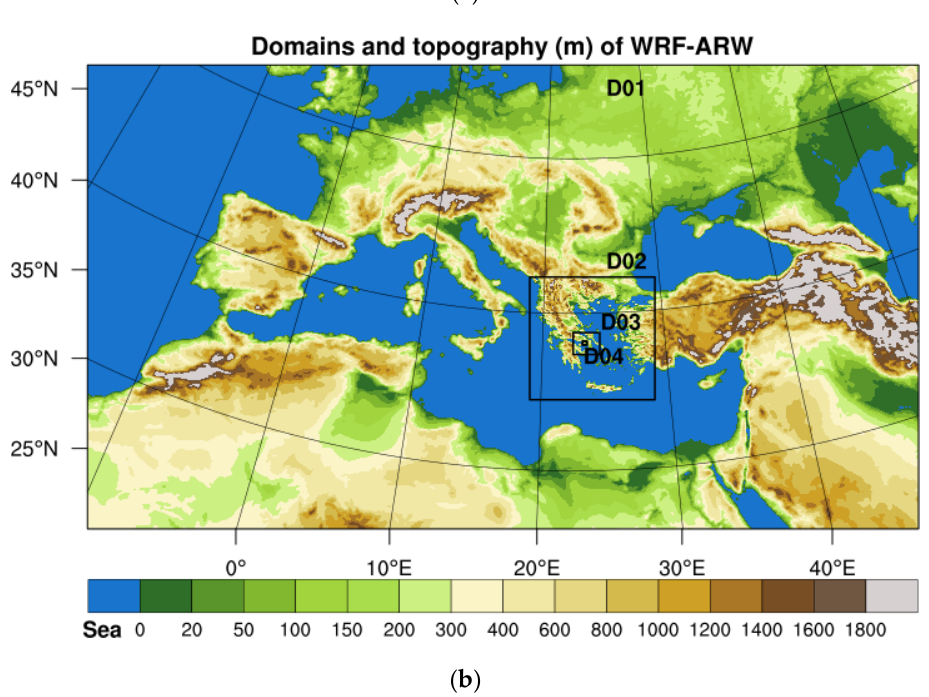
Figure 2. ( a ) LAPS model domain and topography, ( b ) WRF-ARW model domain and topography of the parent domain covering Europe. The nested WRF-ARW model over Greece (D02) is the same as ( a ).